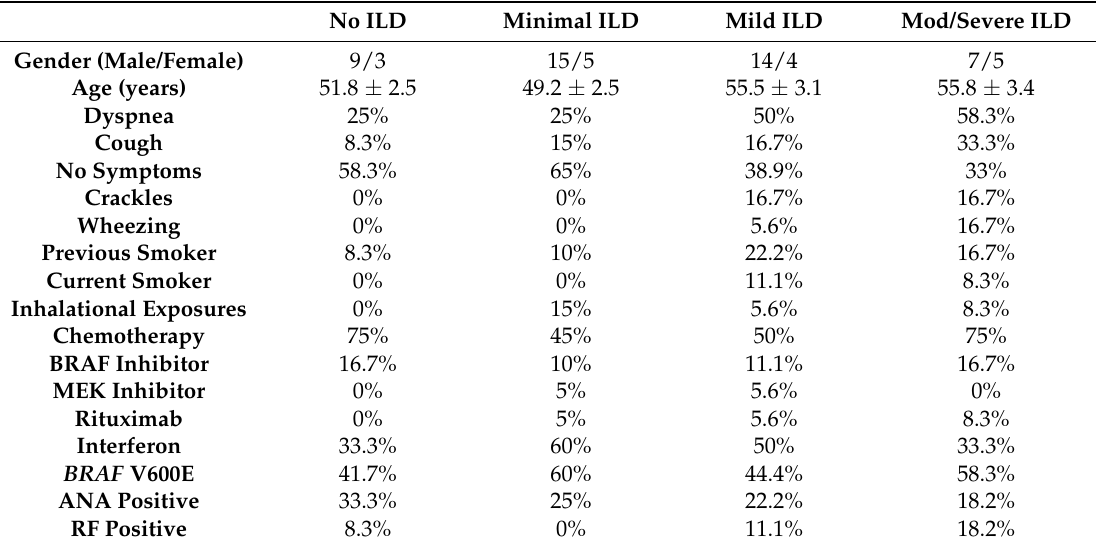
Table 1. Clinical Characteristics of Patients with Erdheim–Chester